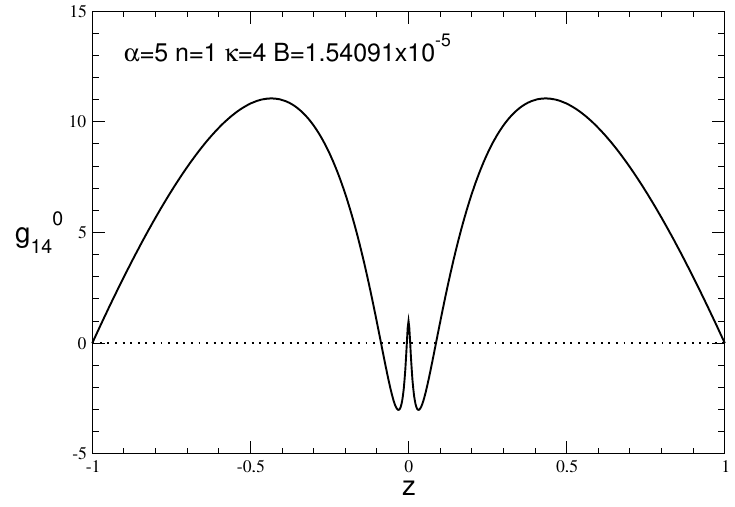
Figure 6. g 0 for state No. 5 ( κ = 4, abnormal) from Table 1. (Adapted from 14